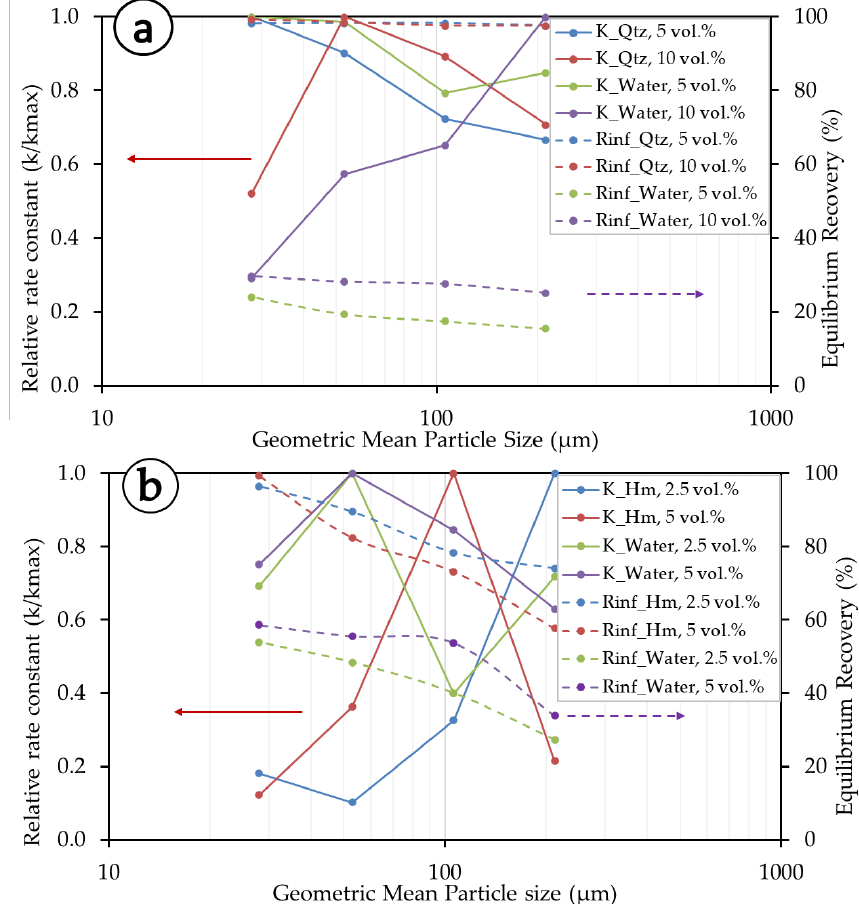
Figure 6. Kinetic parameters for the Gamma model. ( a ) Quartz systems and ( b ) hematite systems. Data points are only connected with lines to provide a visual aid.